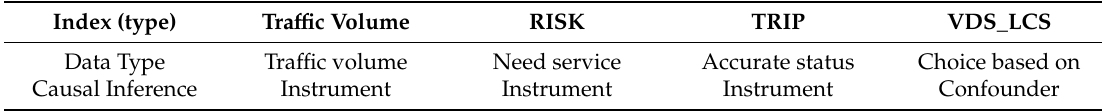
Table 3. Data type and causal inference in database of “Different way to work”.